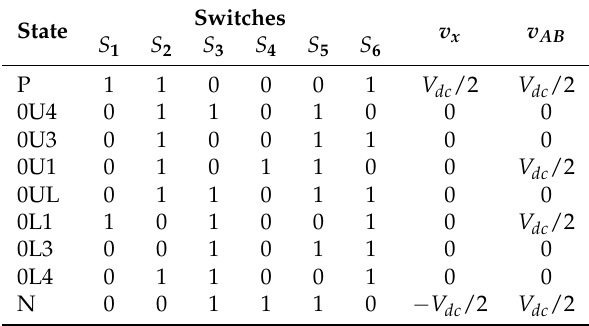
Table 1. Switching states of the three-level ANPC-3P voltage source inverter.